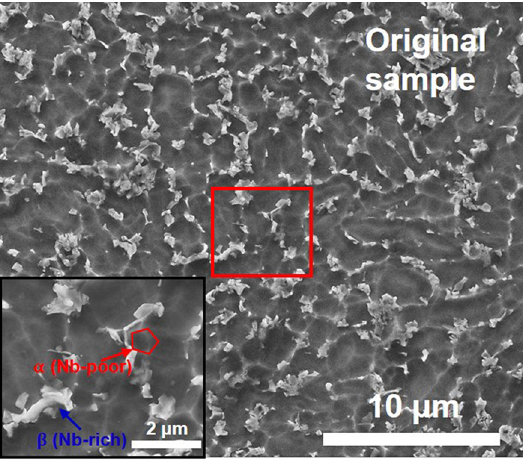
Figure 3. SEM image of the original sample.